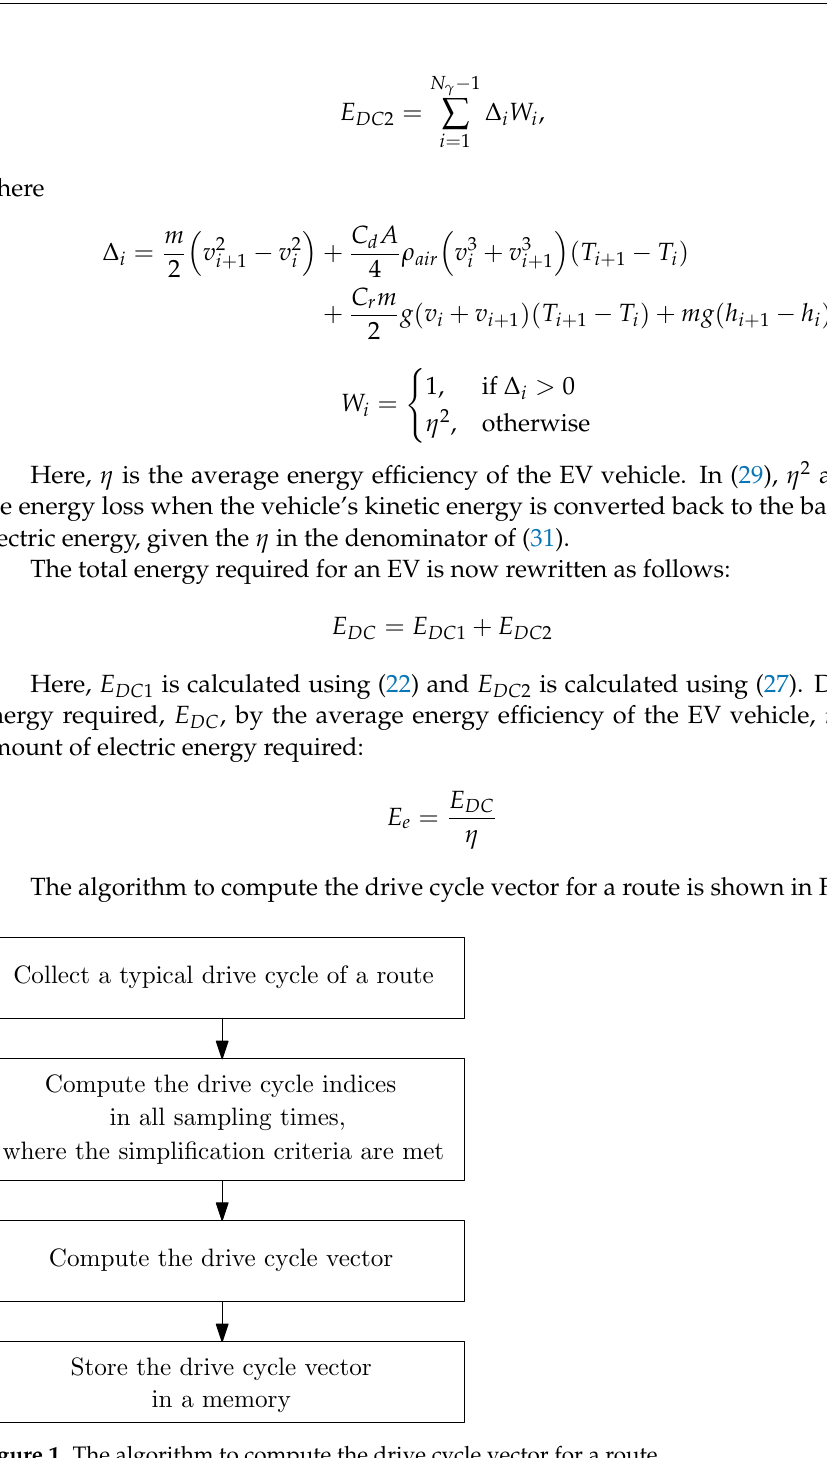
Figure 1. The algorithm to compute the drive cycle vector for a route. The algorithm to compute the total fuel or electricity requirement for a route is shown in Figure